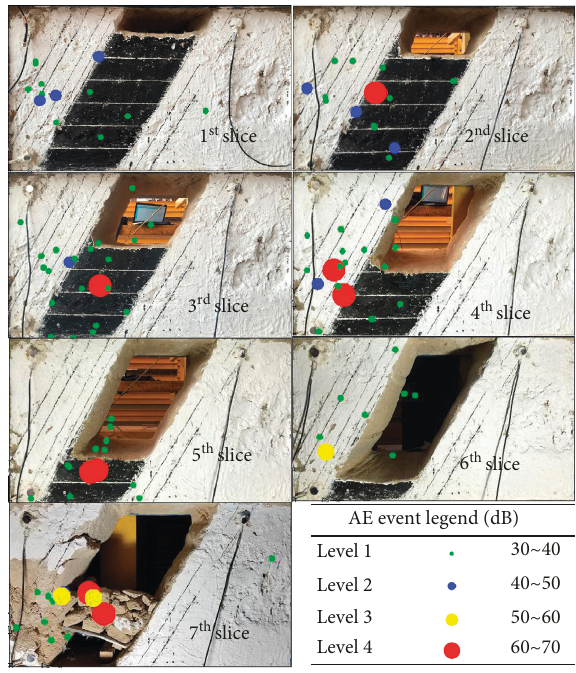
Figure 6: AE positioning results in the test of each